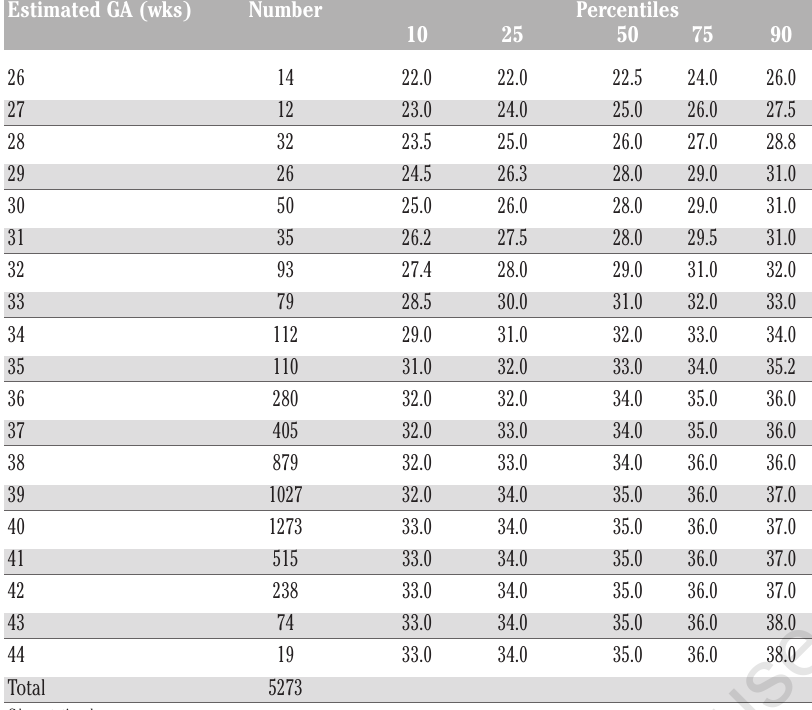
Table 3. Occipito-frontal circumference percentiles by gestational age categories. Estimated GA